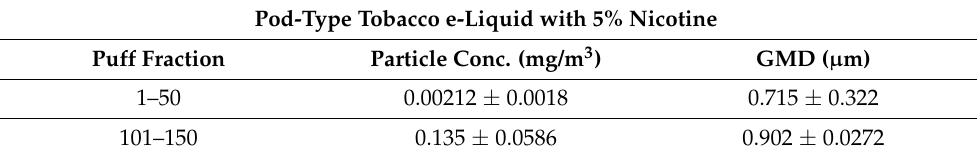
Table 1. Pod-type ENDS-emitted aerosol concentration and mean diameter at different puff